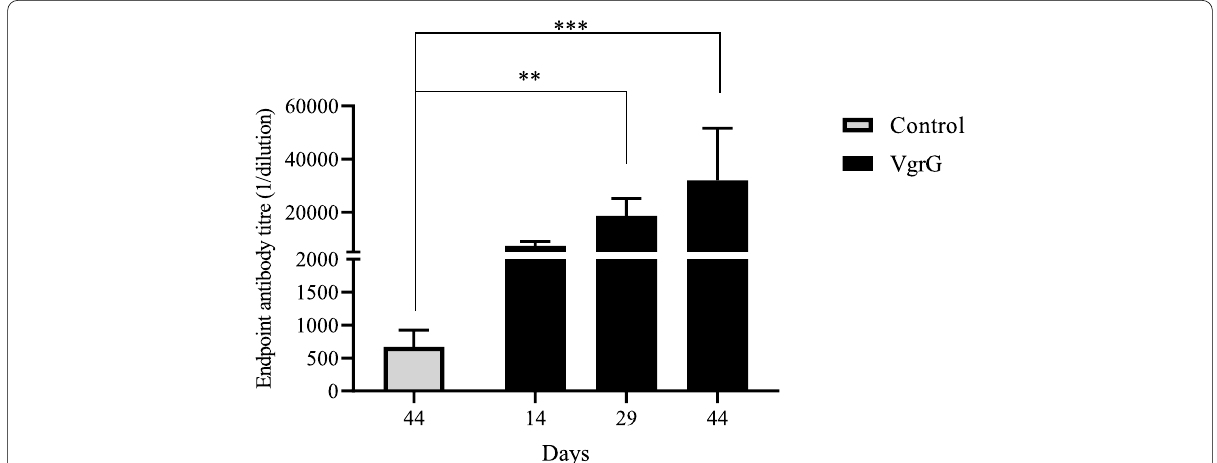
Fig. 1 IgG titers determined by indirect ELISA against the recombinant VgrG. The endpoint titer was defined as the highest dilution at which the optical density was 0.1 greater than that of the control wells receiving control adjuvant serum. Comparisons between the groups were performed